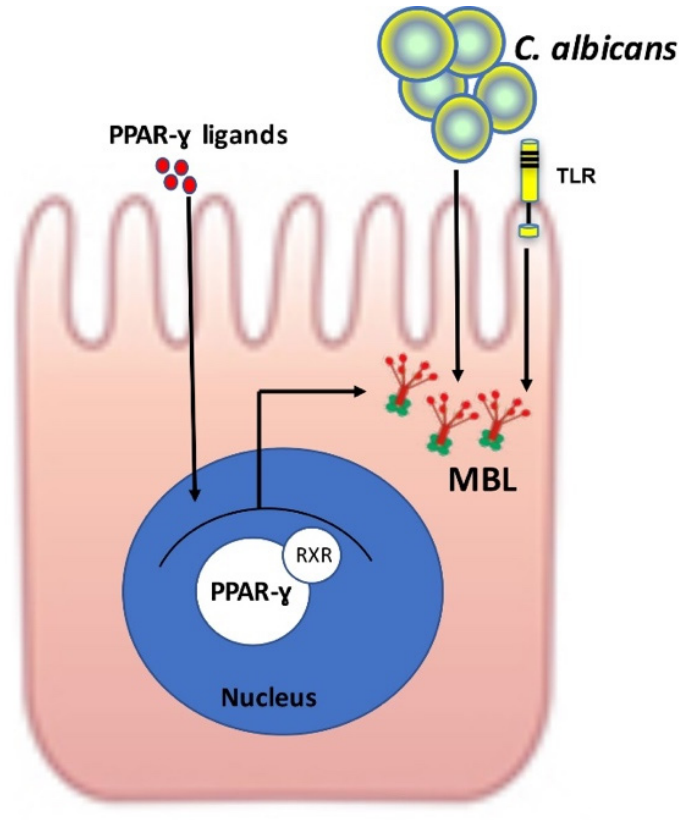
Figure 3. Expression of MBL in epithelial cells in response to C. albicans sensing and PPAR γ activation. Epithelial cells produced MBL after C. albicans sensing alone or with PPAR γ agonist pioglitazone treatment [56]. PPAR γ and TLR sensing by C. albicans led to MBL production in the epithelial cells.